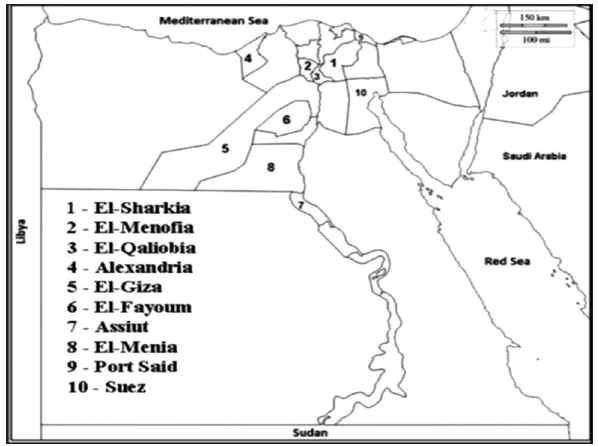
Figure-1: Ten Egyptian Governorates included in the study (area of